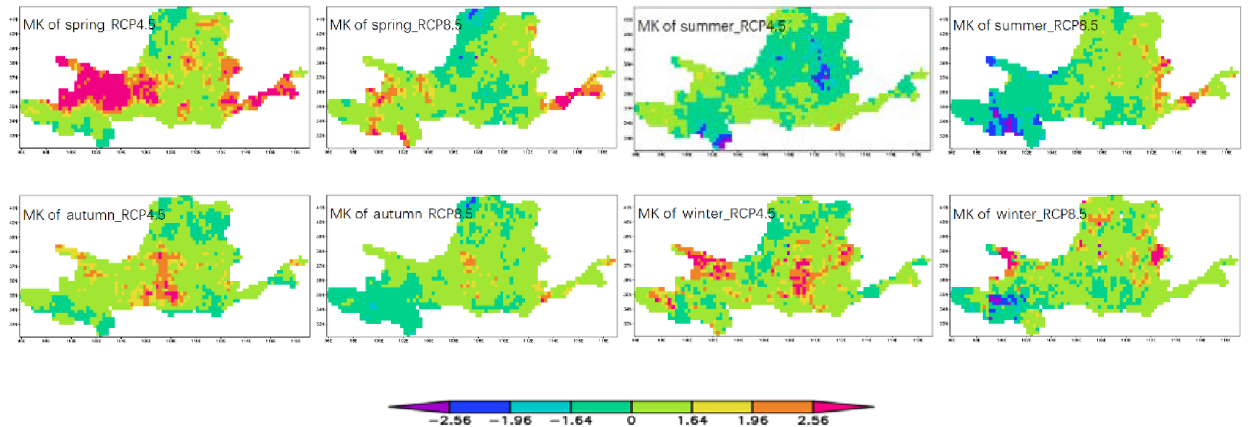
Figure 7. The spatial distribution of Mann-Kendall trend test of the streamflow during 2021 to 2050 in the YRB for two scenarios.